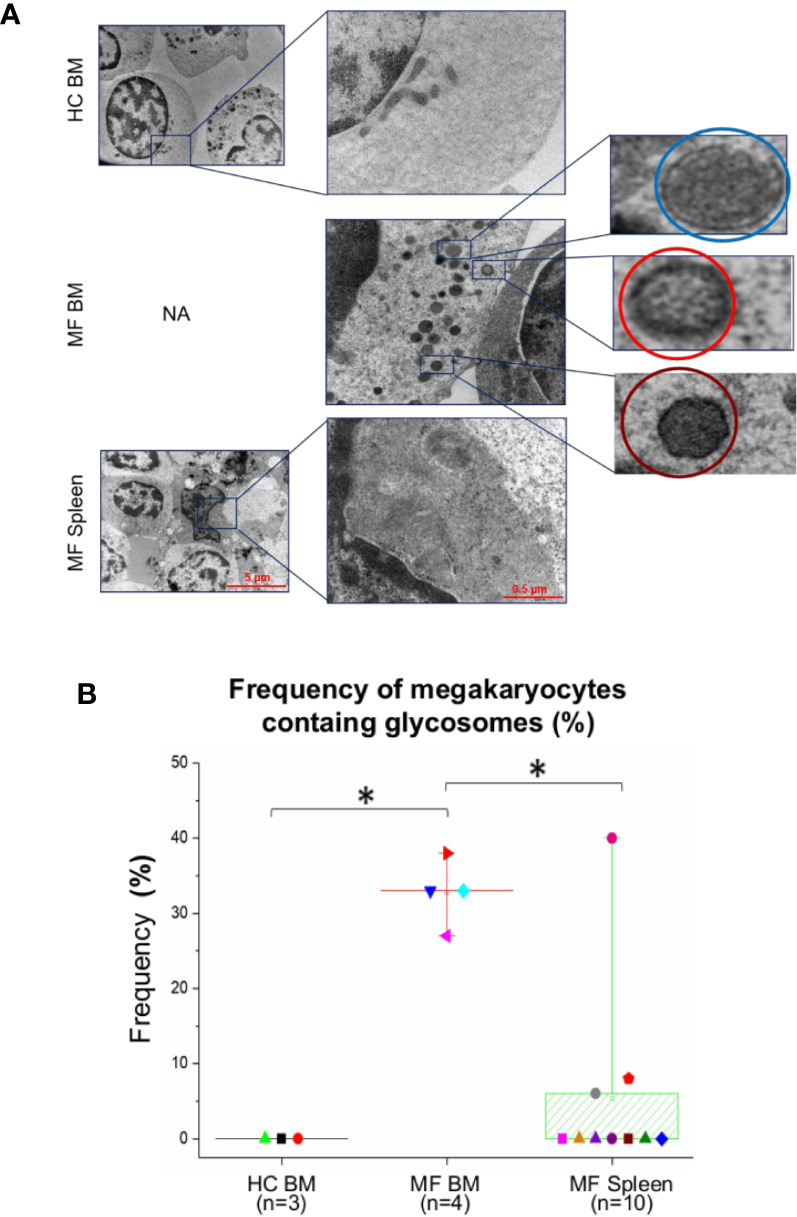
The cytoplasm of numerous megakaryocytes from bone marrow (BM) of MF patients contains structures with ultrastructural features resembling glycosomes at various stages of maturation. (A) Representative megakaryocytes (magnification: 5,800×, scale bar = 5 μm) from the various experimental groups with corresponding enlarged details (magnification: 37,000×, scale bar = 0.5 μm) of their cytoplasm, as indicated. The circles in the enlarged panel of MF BM indicate glycosomes composed by granules with the electron density characteristics of immature-acid soluble (blue) and mature acid-insoluble (red) polyglucosan granules and of a glycosome resembling a Lafora body (see Figure S2 for further detail). (B) Frequency, as median (lines across boxes), 25–75% inter-quartile range (boxes), and maximum and minimum values (the end of the vertical line across the boxes) of megakaryocytes presenting glycogen droplets in the three groups. n = number of subjects included in each experimental group (see legend of Figure 1 for further detail). The number of cells analyzed per group is reported in the legend for Figure 4. HC, healthy control; NA, not available.